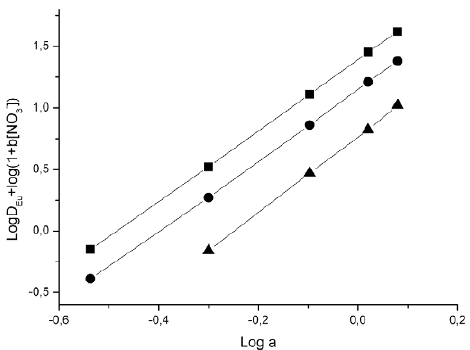
Figure 1. Dependence of Eu(III) extraction on the activity of NH 4 NO 3 in aqueous phase with 0.01 M solutions of compounds 3 , 6 and 7 in